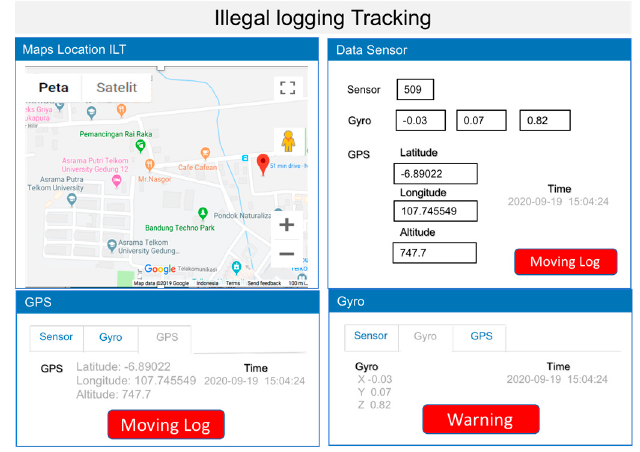
Figure 15. Web Display of Illegal Logging Tracking Application.